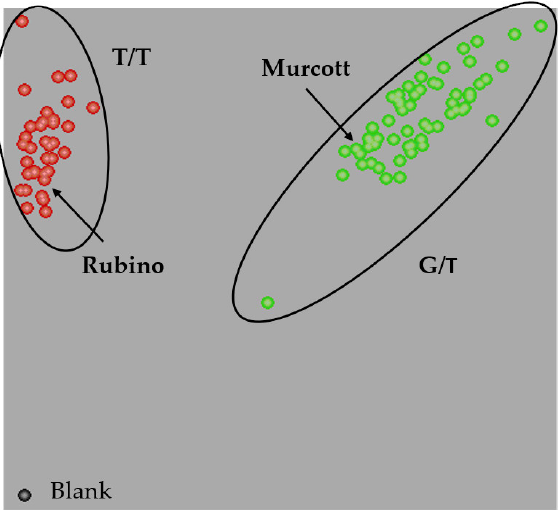
Figure 6. KASPar genotyping results for the SNP08 for the Rubino × Murcott population. Resistant hybrids are represented by red points (T/T); susceptible hybrids are represented by green points (G/T).